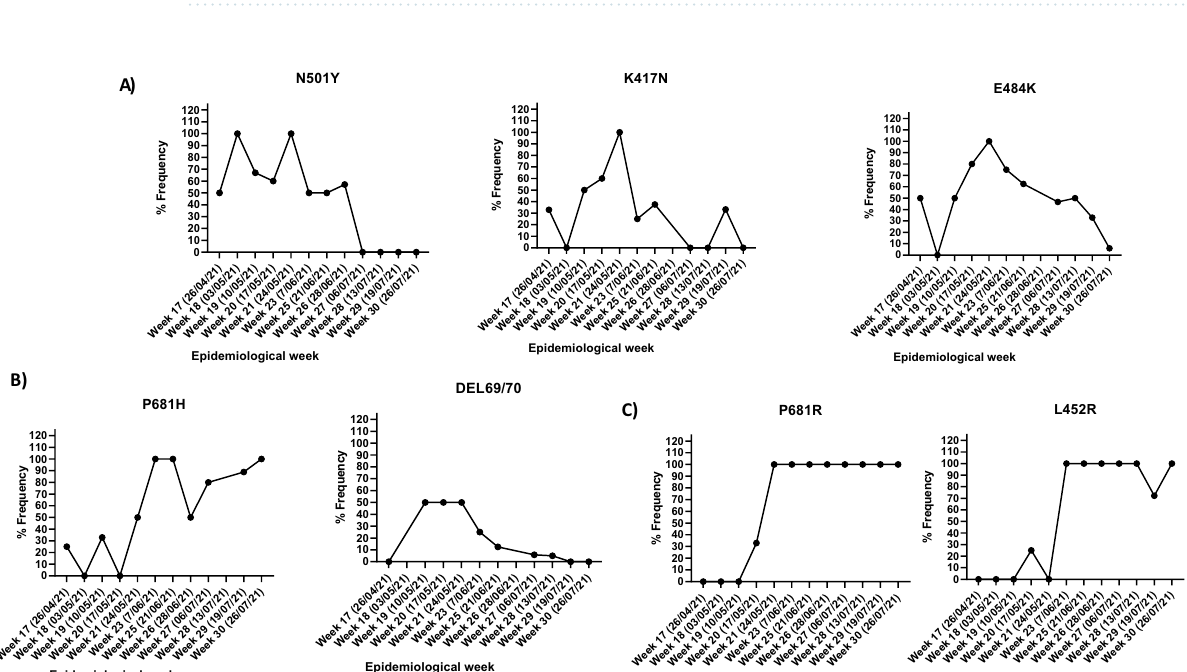
Figure 2. Mutation frequency linked to key Variants of Concern (VOC). Frequency of viral RNA showing spike protein mutation linked to the ( A ) Beta variant with three key substitutions in the RBD (K417N, E484K and N501Y), ( B ) the Alpha variant with the N501Y, P681H and 69/70 Deletion and, ( C ) the Delta variant harbouring mutations for P681R and